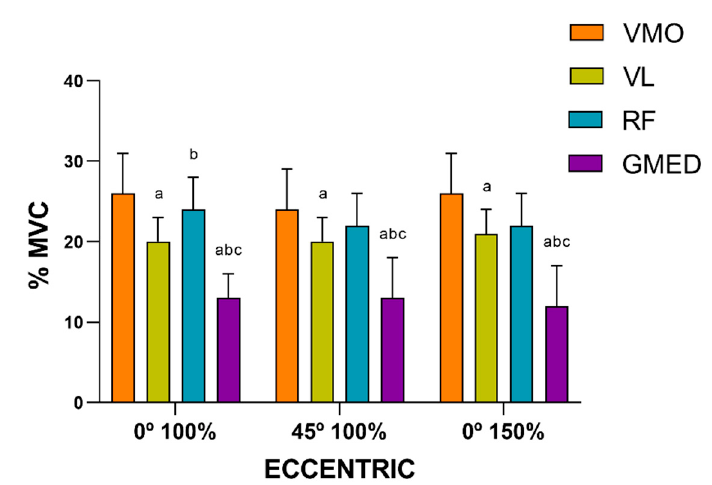
Figure 4. Comparison of the muscle activation (expressed in %MVC) between the muscles during the eccentric phase under each condition, performed at the controlled velocity ( ᵃ difference from VM, ᵇ difference from VL, c difference from RF; p < 0.05). VMO: vastus medialis oblique; VL: vastus lateralis; RF: rectus femoris; GMED: gluteus medialis.